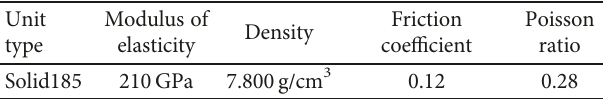
Table 7: Physical and mechanical properties for building the fi nite element models.